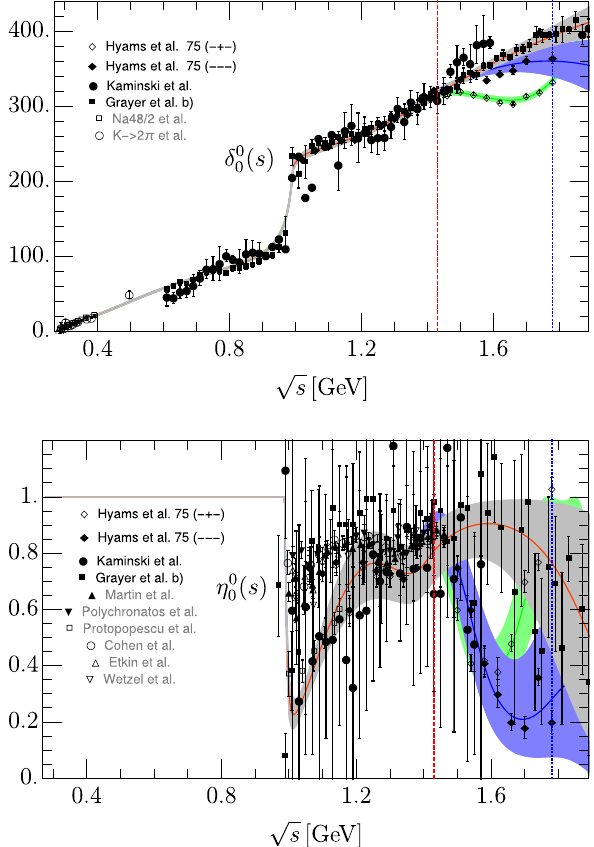
Fig. 1 Comparison of solutions I, II and III (Tables 1, 2, 3) versus data. The gray, blue and green bands correspond to the uncertainty of solutions I, II and III, respectively. Above 1.4 GeV, solution I fits the data of [5,64] (solid circles) and [2,3] (solid squares), solution II fits [4] (soliddiamonds)andsolutionIIIfitstheupdated( − + − )datafrom[58] (hollow diamonds). The data coming from [9] (empty squares) and [65] (emptycircles)forthephaseshiftand[66](solidtriangleup), [67](solid triangle down), [6] (empty squares), [65] (empty circles), [68] (empty triangle up) and [69] (empty triangle down) for the elasticity are just shown for comparison. The red-dashed verticallineseparates the region where the fits describe both data and dispersion relation results, from the region above, where the parameterization is just fitted to data. The blue-dotted vertical line stands at the energy of the last data point of solutions II and